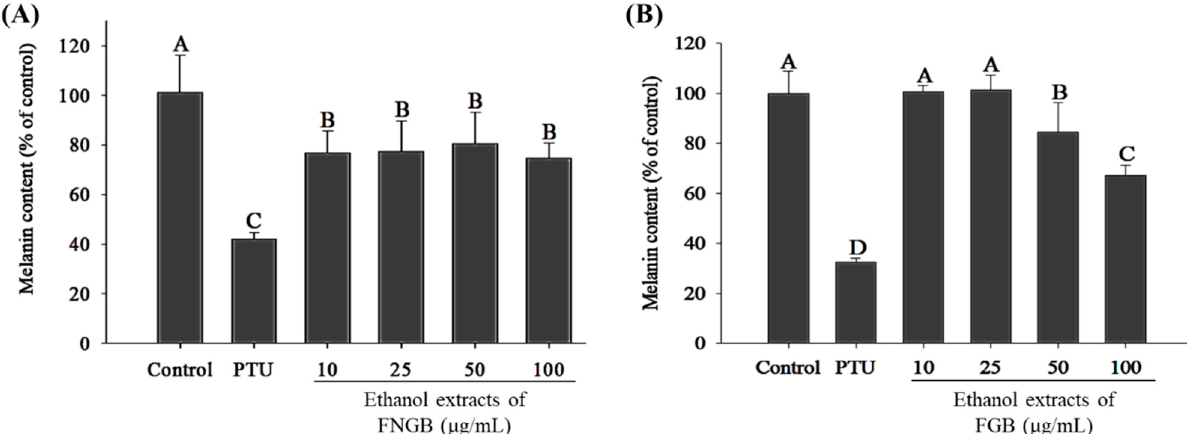
Figure 6. Effects of ethanol extracts of fermented-nongermination black soy milk ( A ) and fermented-germination black soy milk ( B ) on melanin contents in zebrafish embryos. Zebrafish embryos were treated with several concentrations’ ethanol extracts of fermented-nongermination black soy milk or fermented-germination black soy milk (10–100 µg/mL) from 7 to 55 hpf. Melanin was dissolved with 1 N NaOH at 100 °C. The data are presented as means ± SD ( n = 3). Values with different uppercase letters were significantly different based on Duncan’s multiple range tests ( p < 0.05). PTU, 0.2 mM phenylthiourea; hpf, hours post fertilization; FNGB, fermented-nongermination black soy milk; FGB, fermented-germination black soy milk.